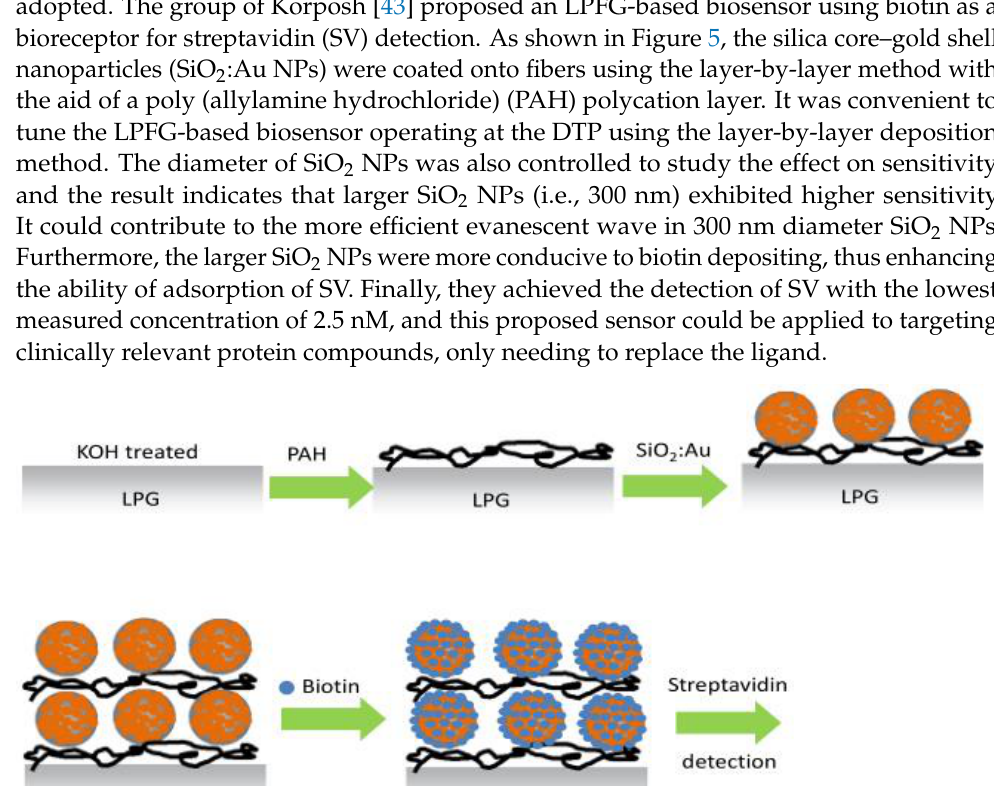
Figure 5. Schematic illustration of the layer-by-layer deposition of a (PAH/SiO 2 :Au) 2 film onto an LPFG. Adopted from [43]. Under a Creative Commons license.